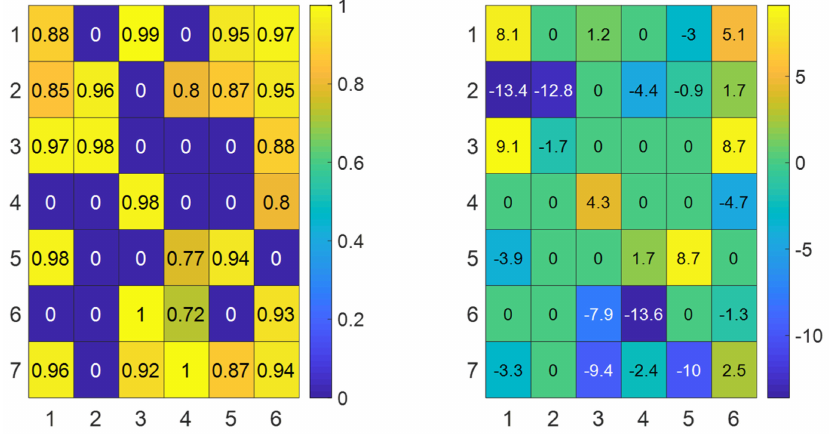
Figure 8. Final position distribution and amplitude and phase distribution of the subarray at 0–degree scan angle.